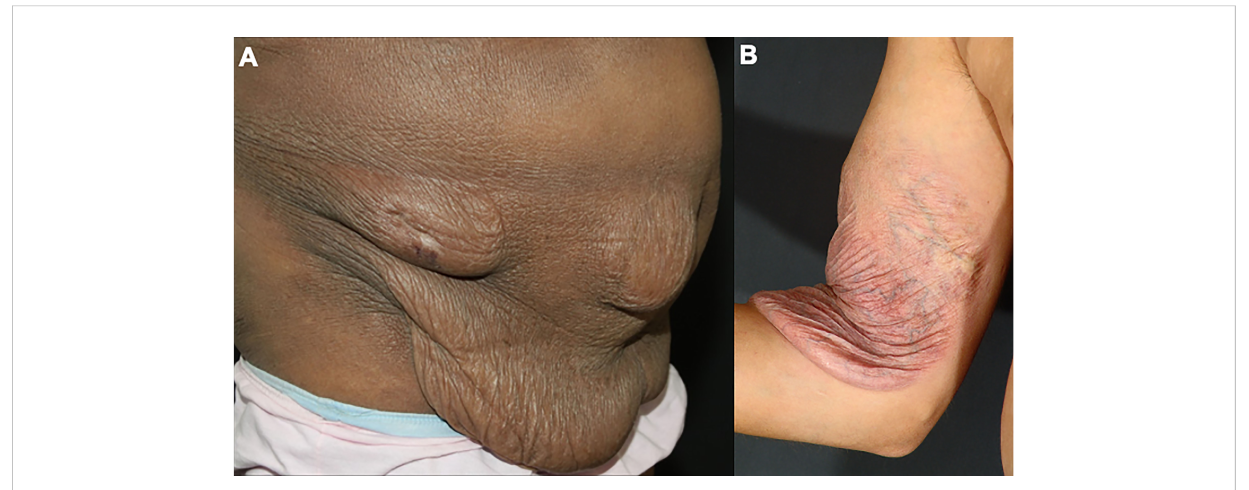
FIGURE 4 Granulomatous slack skin. Skin laxity on the abdomen (A) and the arm (B)